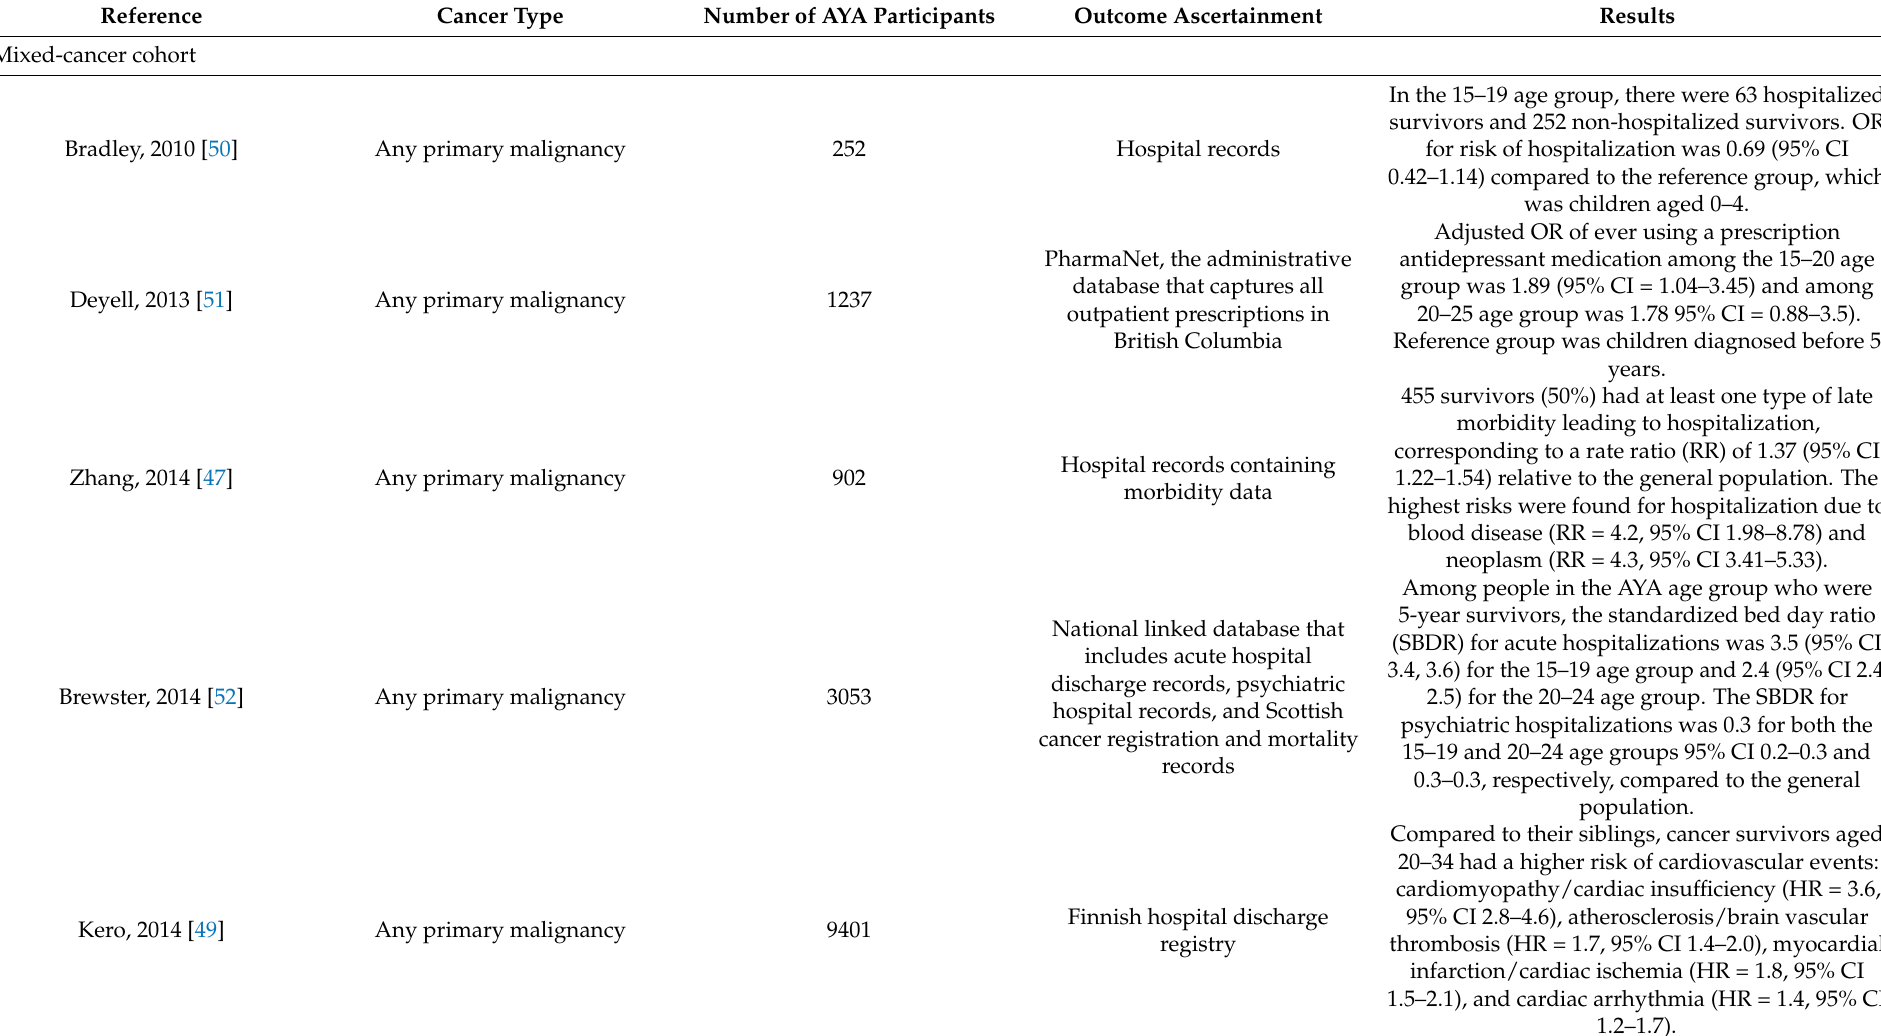
Table 2. The burden of chronic conditions among adolescent and young adult cancer survivors by tumor group (n =